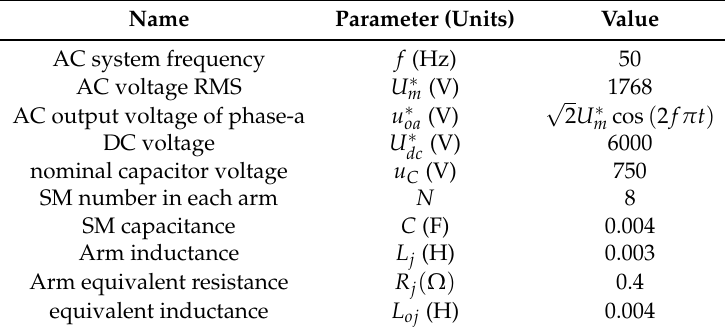
Figure 2. Tracking control block diagram of the study system. Table 1. Parameters of the study system.(note:* represents desired